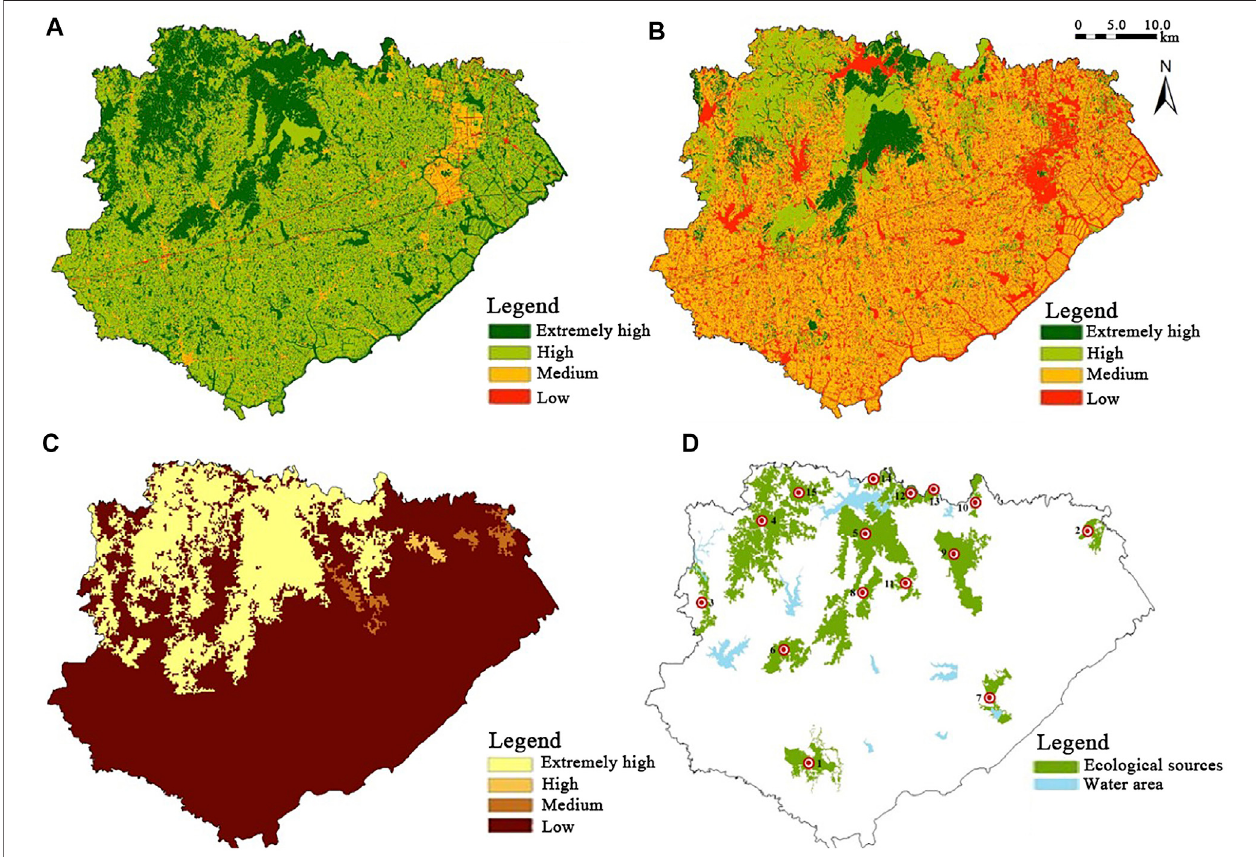
FIGURE 3 | Ecological source areas in Quanjiao County. (a. Habitat quality; b. ecosystem services; c. landscape connectivity; d. ecological source.)